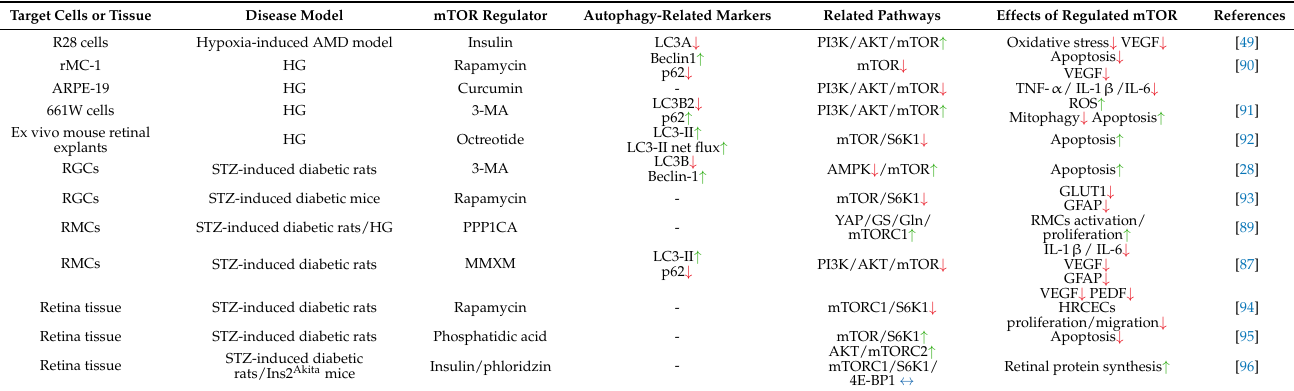
Table 2. Involvement of mTOR in DR: in vitro and animal